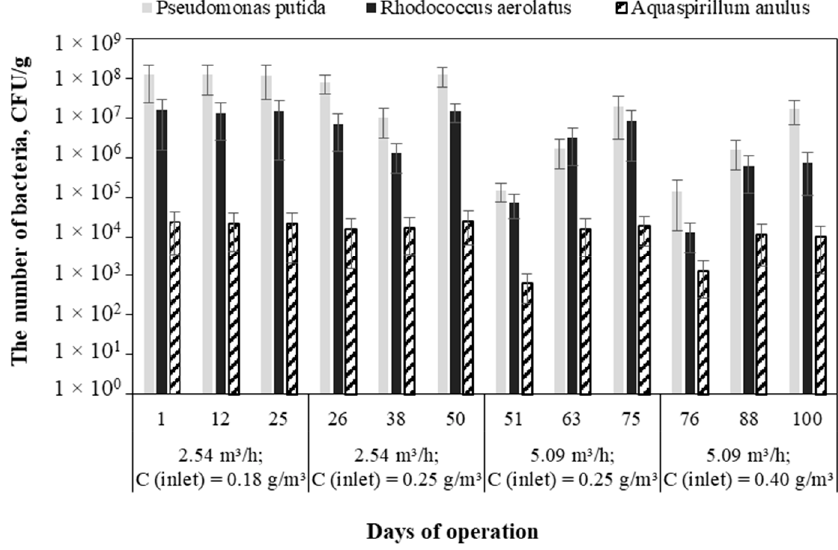
Figure 9. Bacterial community changes in bioball packing material during the biofiltration process.